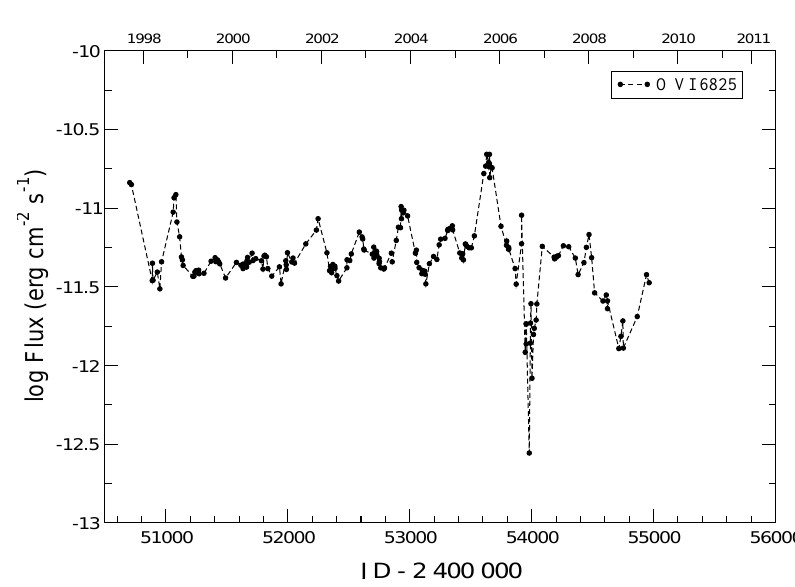
Fig. 8. Absolute (cid:13)uxes emitted in the O VI (cid:21) 6825 line in